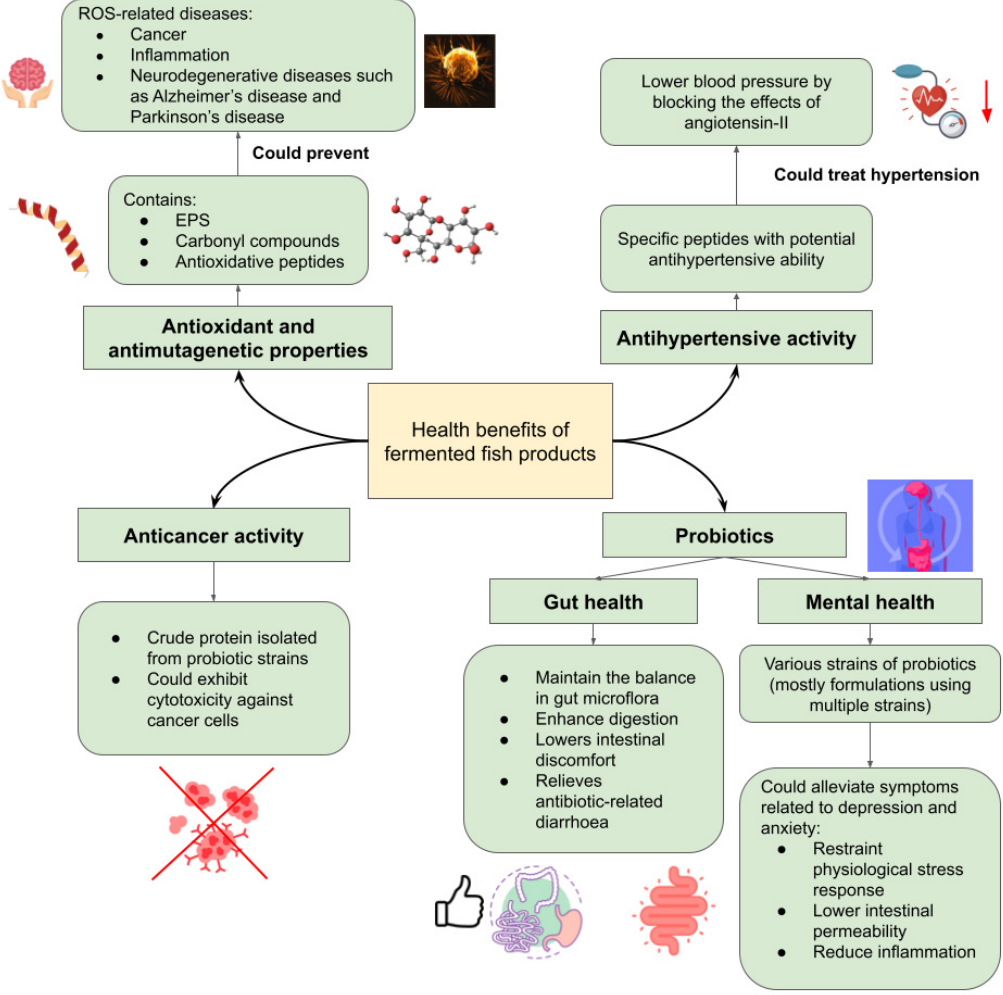
Figure 1. The health benefits of fermented fish products.